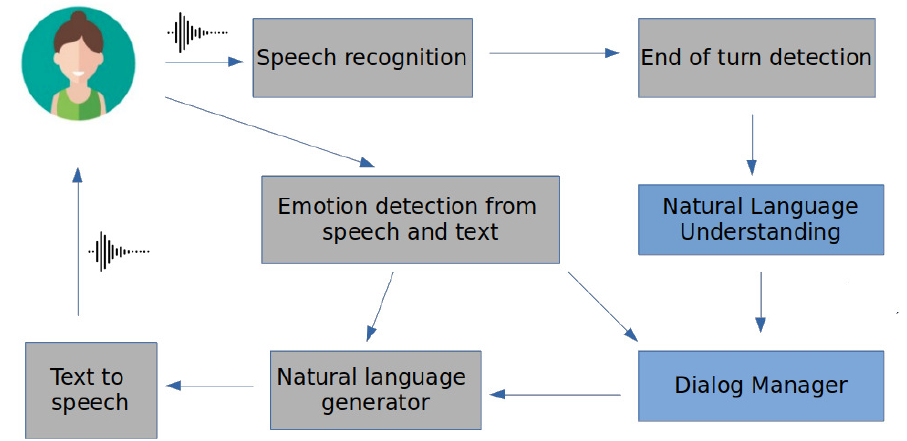
Figure 1. EMPATHIC architecture modules related to the dialogue act taxonomy